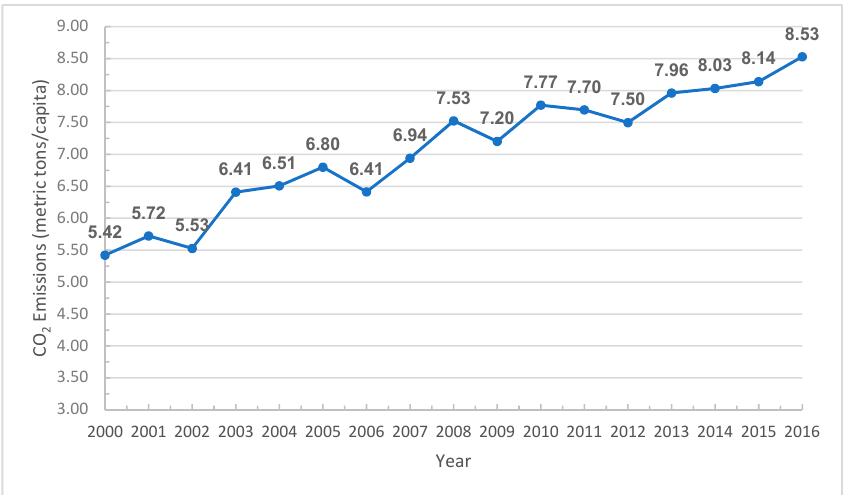
Figure 1. The increasing trend of CO 2 emissions per capita in Malaysia from 2000 to 2016 [4].